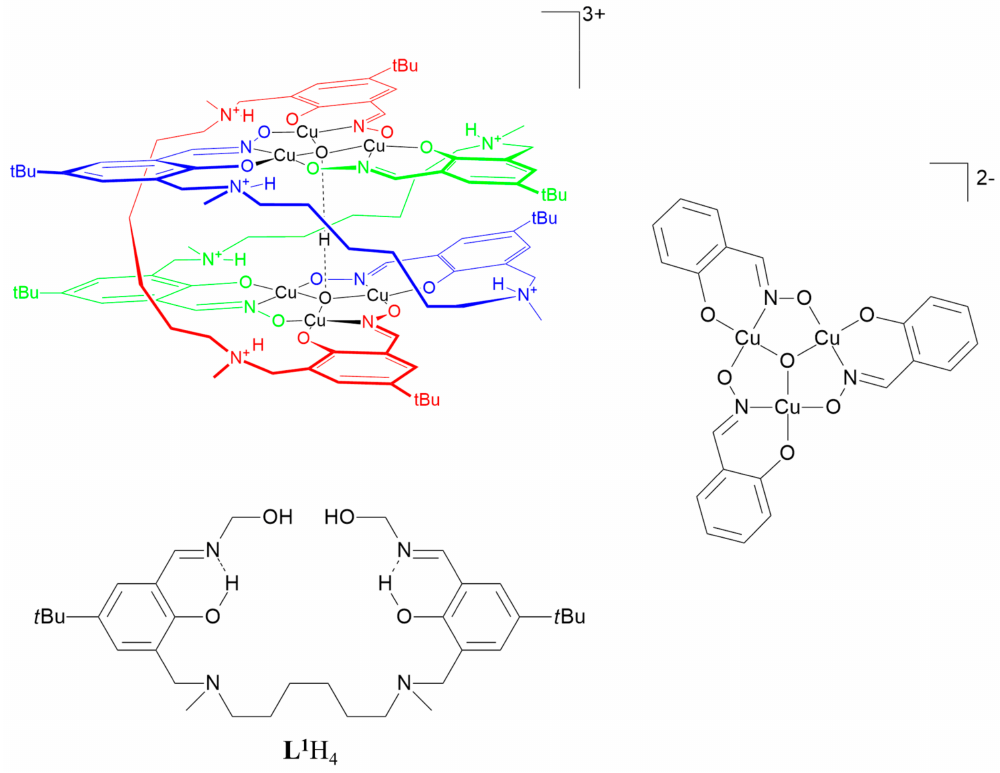
Figure 2. The structure of the hexanuclear complex [{Cu 3 O} 2 H( L 1 H 2 ) 3 ] 3 − derived from L 1 H 4 and a representation of the triangular cores